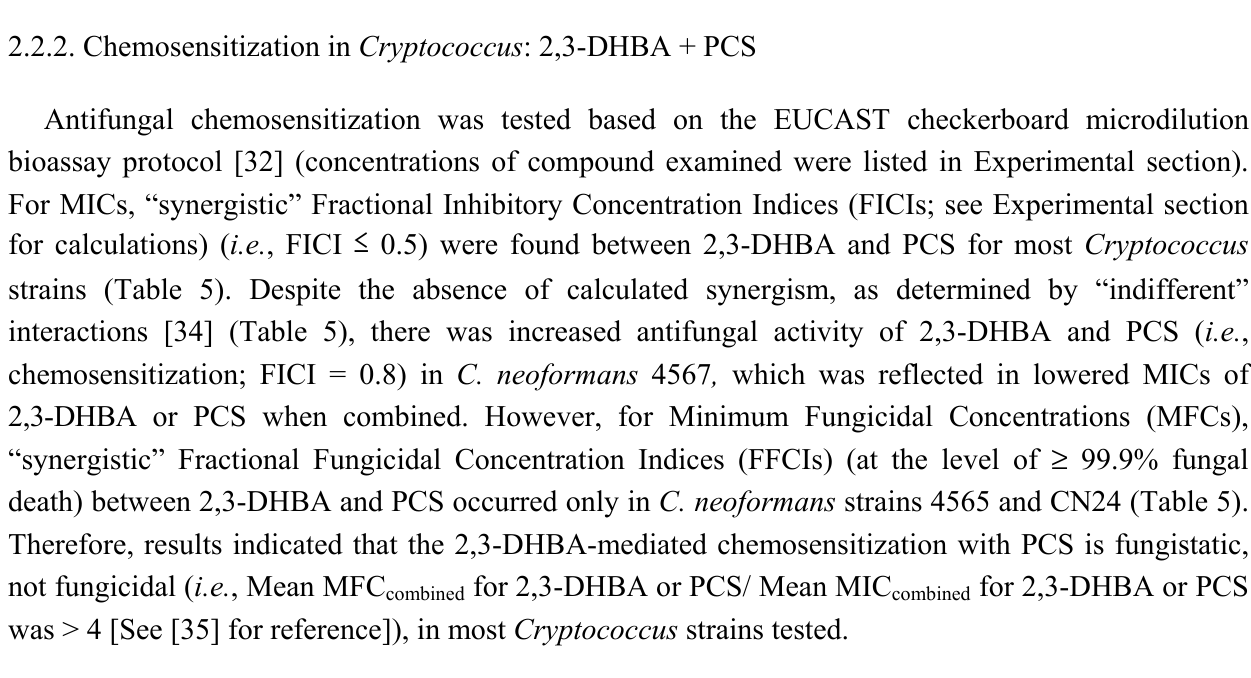
Table 5. Antifungal chemosensitization of 2,3-DHBA (mM) to PCS ( μ g/mL) tested against Cryptococcus strains: EUCAST-based microdilution bioassays.